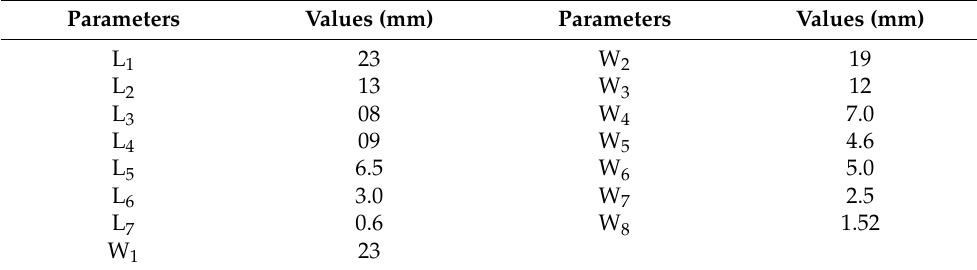
Figure 1. The configuration of the proposed antenna. ( a ) Top view; ( b ) Bottom view; and ( c ) Side view. Table 1. Detailed dimensions of the proposed antenna.